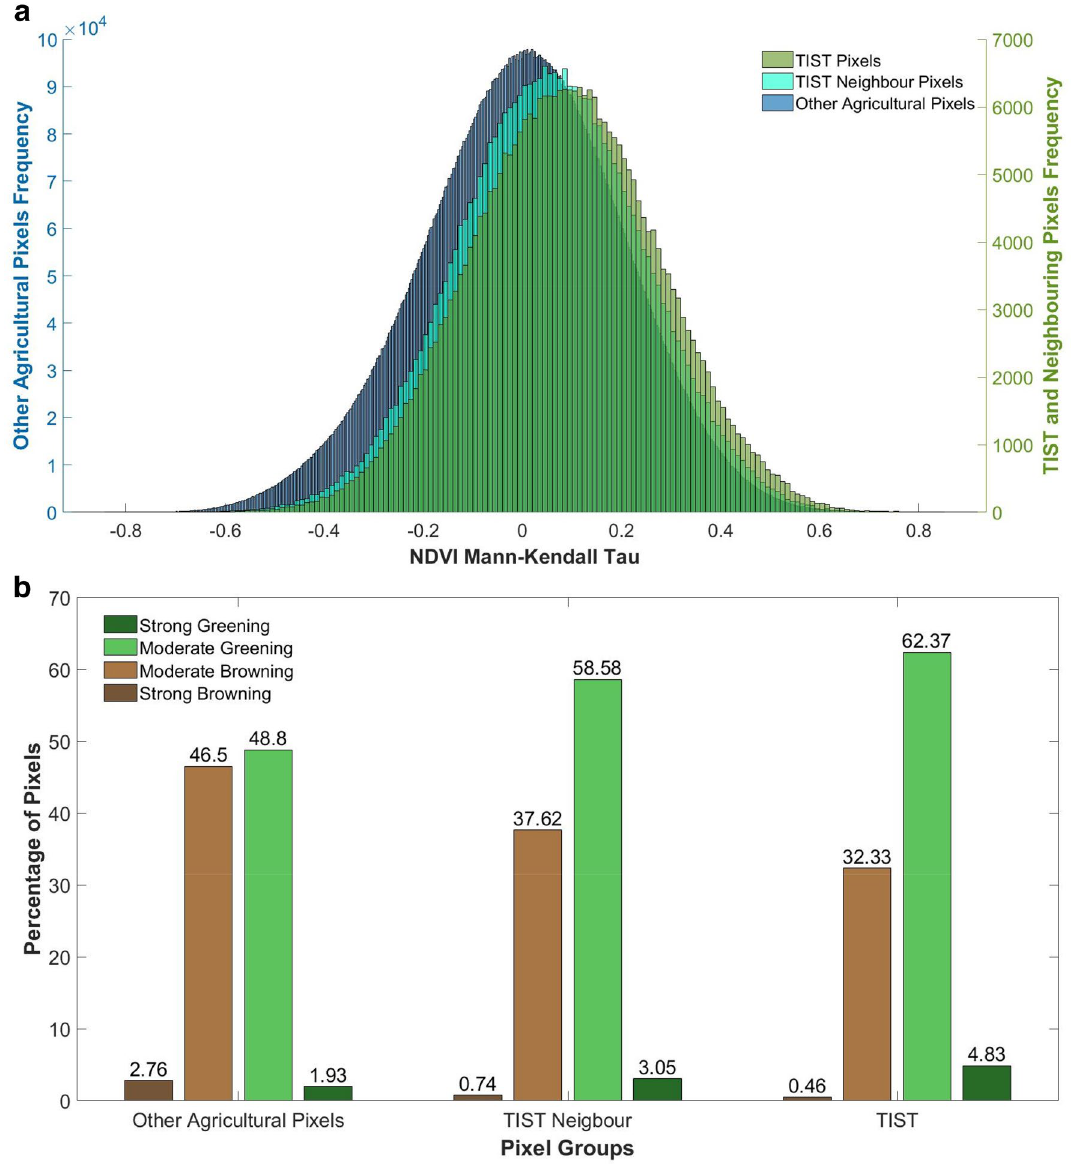
Figure 2. Greening trends across study area: (a) distribution of NDVI Kendall Tau for TIST groves, neighbouring pixels and other agricultural pixels within the study area. Trends in NDVI Kendall Tau are positively shifted for TIST groves and neighbouring pixels relative to other agricultural pixels within the study area. (b) Classified greening and browning trends within TIST groves, TIST Neighbour pixels and other agricultural pixels. Based upon Mann–Kendall Tau values pixels are binned into ordered groups showing “strong browning” (−0.8 < τ < −0.4), “moderate browning” (−0.4 < τ < 0), “moderate greening” (0 < τ < 0.4) and “strong greening” (0.4 < τ < 0.8), following Gichenje and Godinho 23 . TIST grove pixels and TIST neighbouring pixels show a larger proportion of greening pixels than other agricultural land. Over 67% of TIST grove pixels show some form of greening compared to 51% of other agricultural